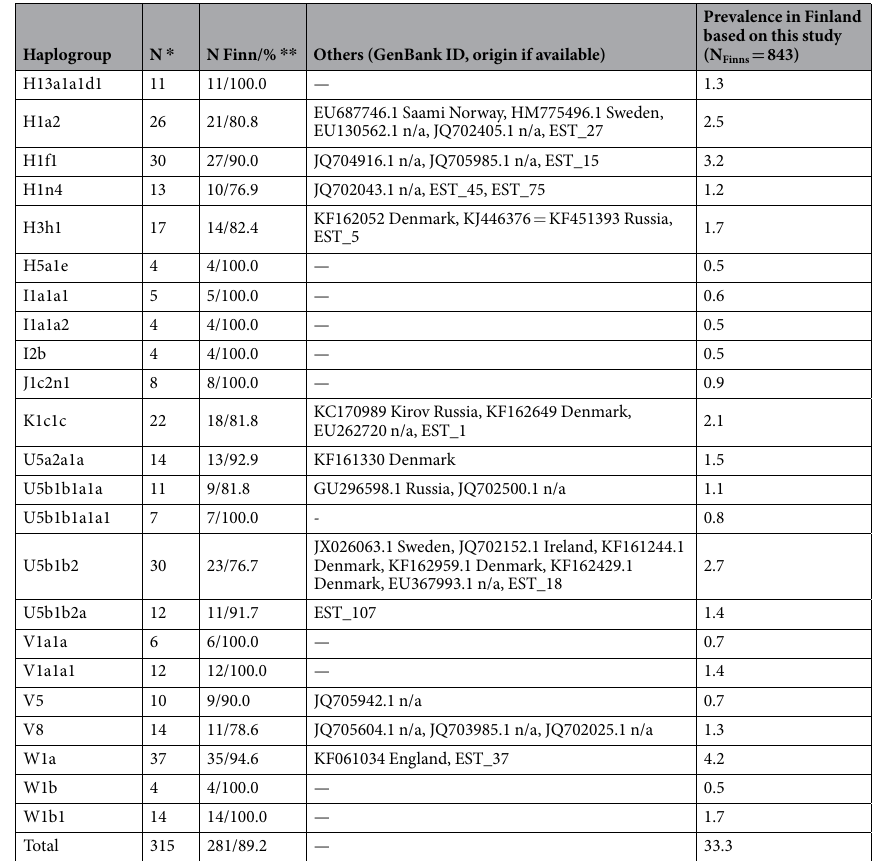
— Table 3. Finn-characteristic haplogroups. Estonian samples (EST_27, EST_15, EST_45, EST_75, EST_5, EST_1, EST_18, EST_107 and EST_37) from Stoljarova et al . 70 . n/a = ethnic/geographical origin for